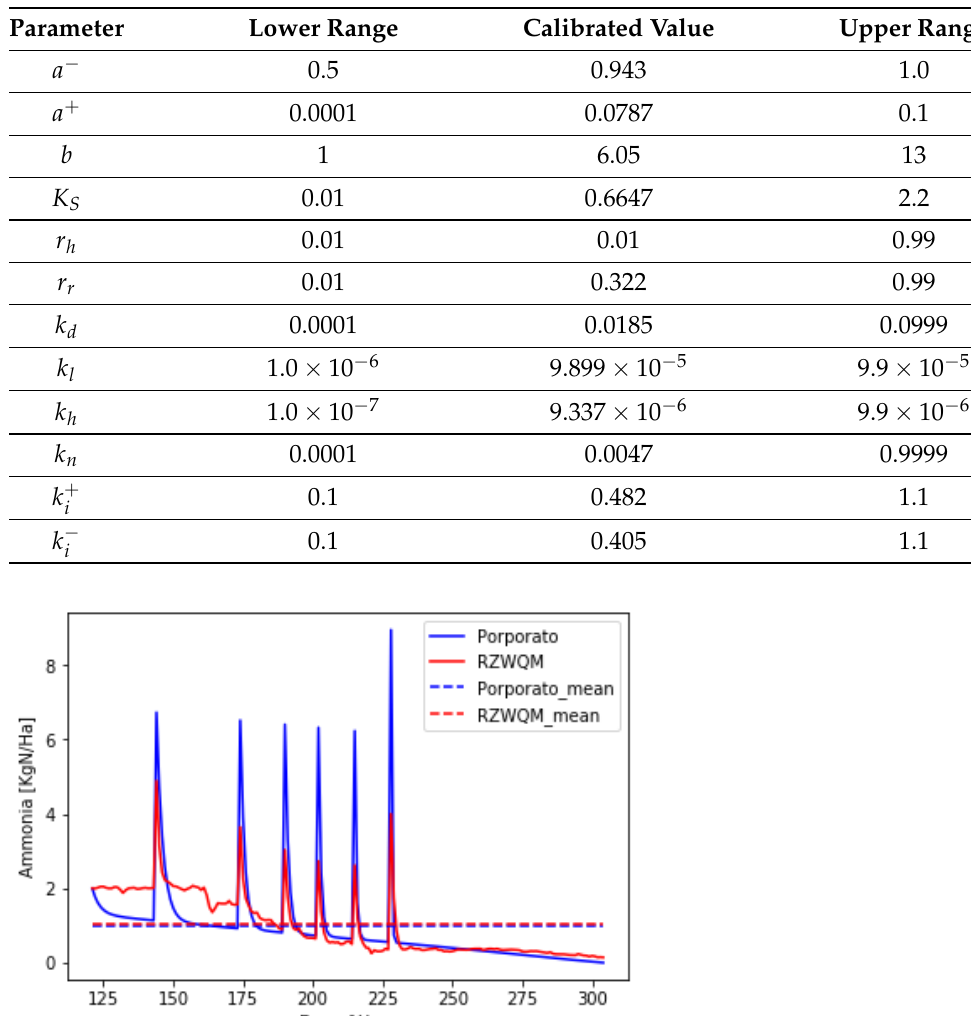
Table 2. Calibrated nutrient parameters’ values for the lean N-model.